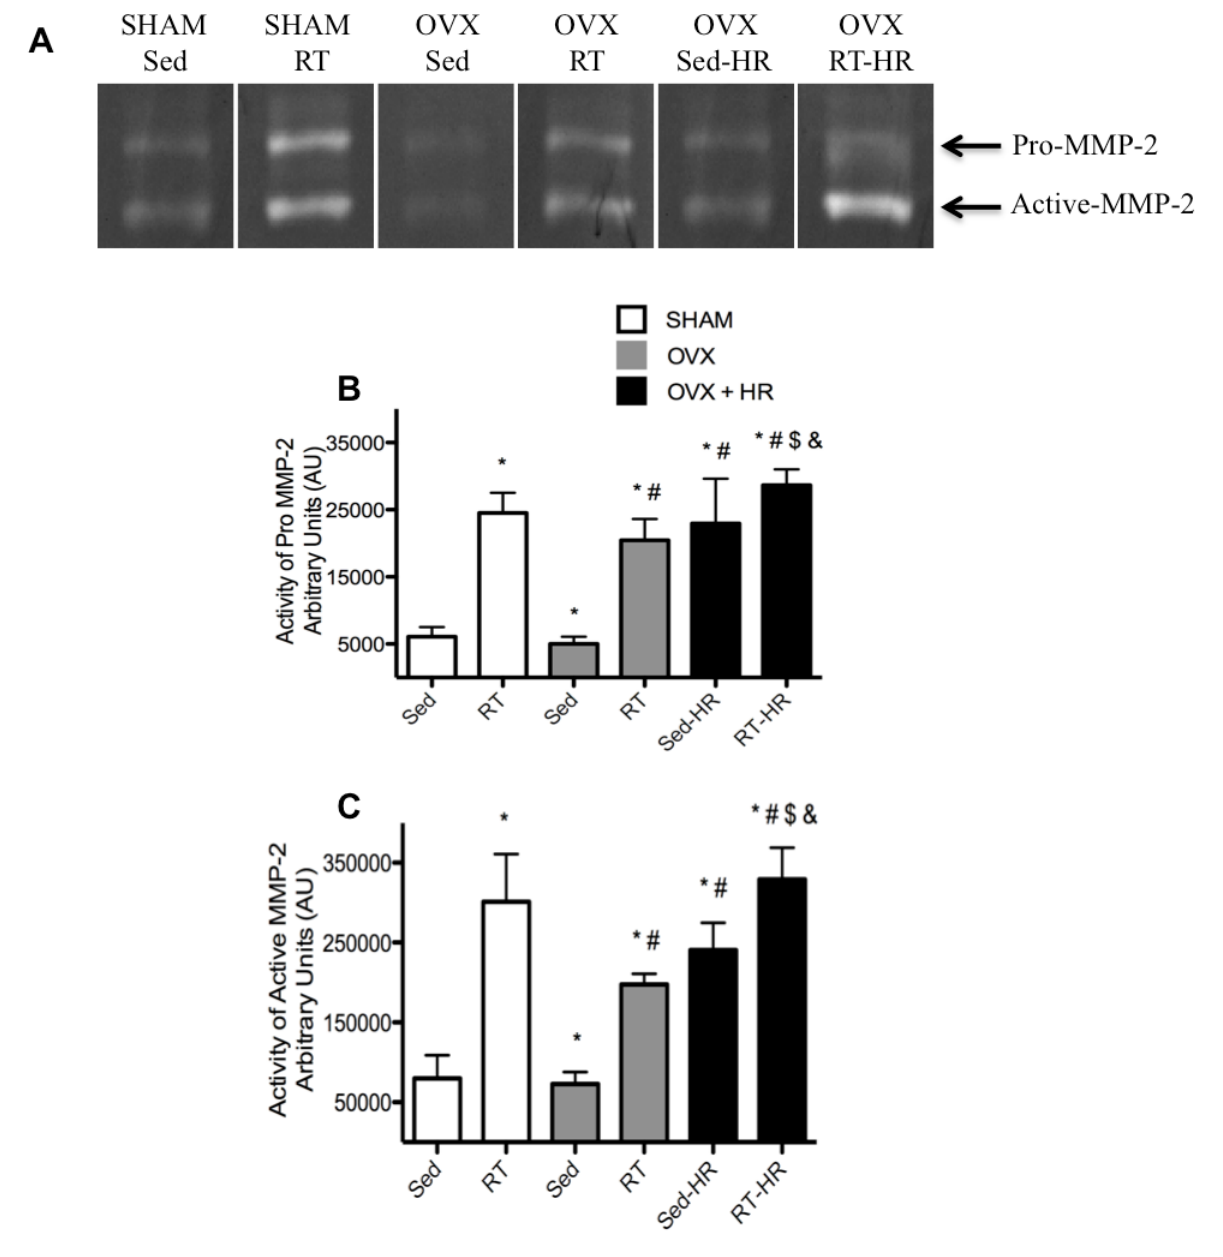
FIGURE 4: Effects of resistance training (RT), ovariectomy and hormone replacement (HR) on pro and active MMP-2 bands on the right tibia. Data are expressed as arbitrary units (AU). Values are presented as mean ± standard deviation of mean (SDM), P < 0.05. *Statistical difference compared to SHAM Sed, #Statistical difference compared to OVX Sed, $Statistical difference compared to OVX Sed-HR, and &Statistical dif- ference compared to all